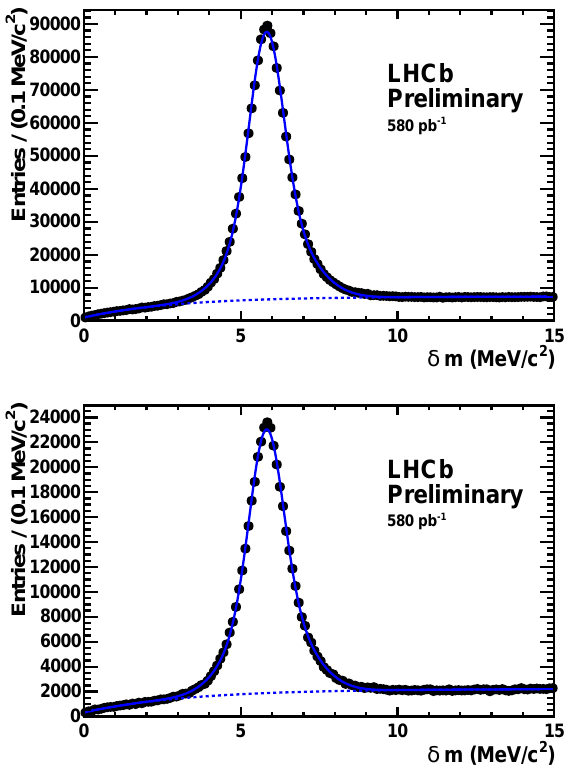
Fig. 2. Fits to the mass di ff erence spectra, where the D 0 is recon- structed in the final states K − K + (top) and π − π + (bottom), with a D 0 mass lying in the window of 1844–1884 MeV / c 2 .